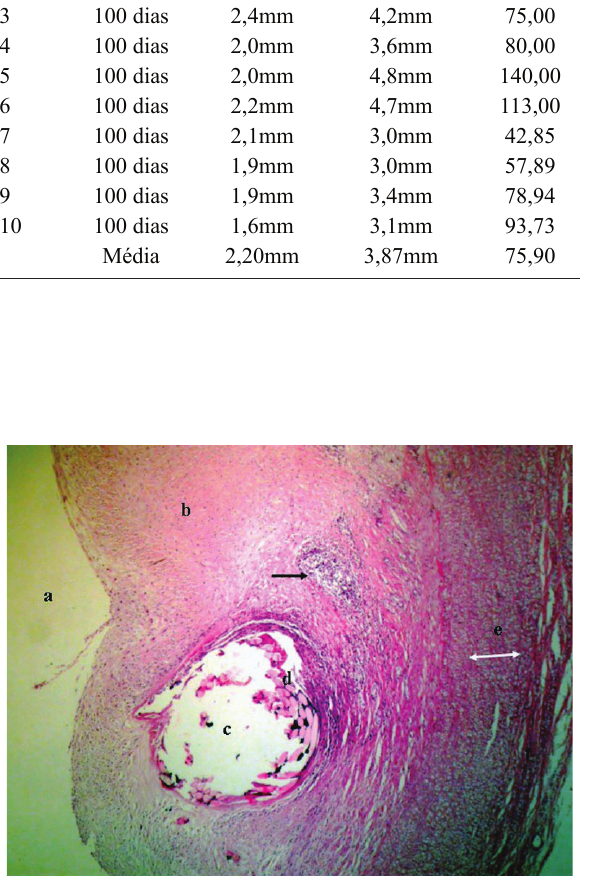
túnica íntima e é caracterizada por proliferação celular e